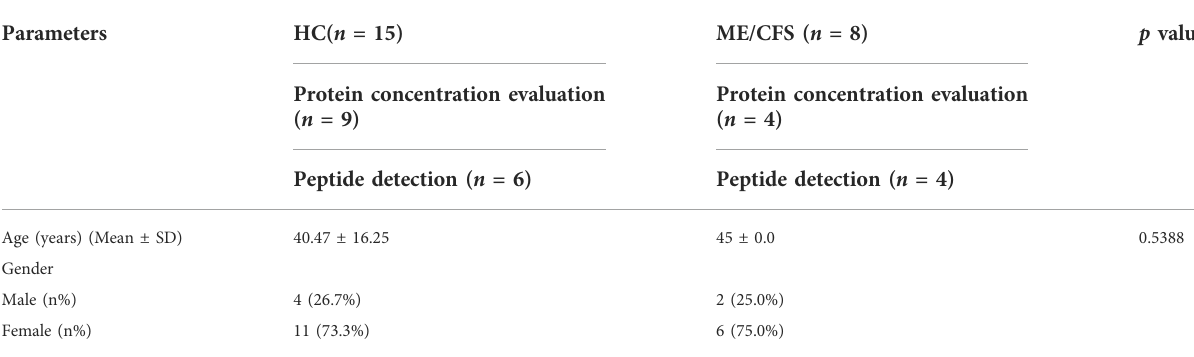
TABLE 1 Demographic results of participants.